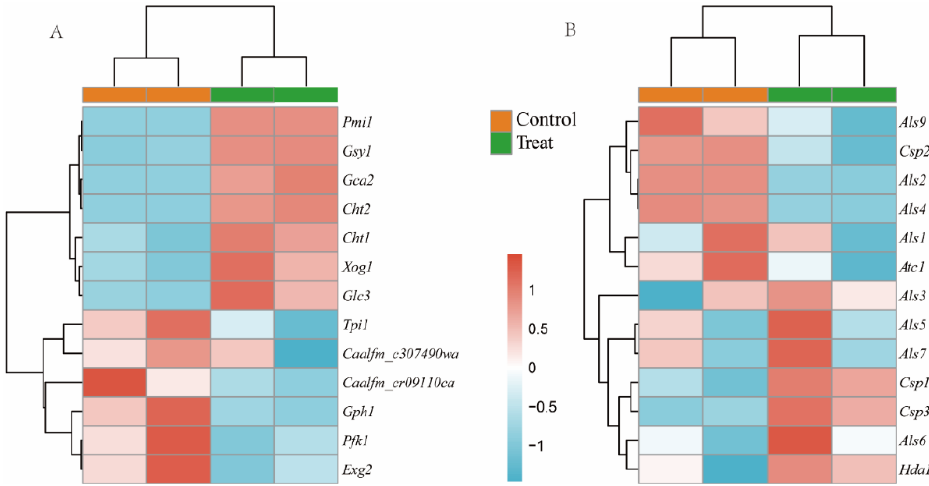
Figure 5. Heatmap for gene expression in C. albicans . ( A ) Genes related to carbohydrate metabolism. ( B ) Genes related to hyphae formation.